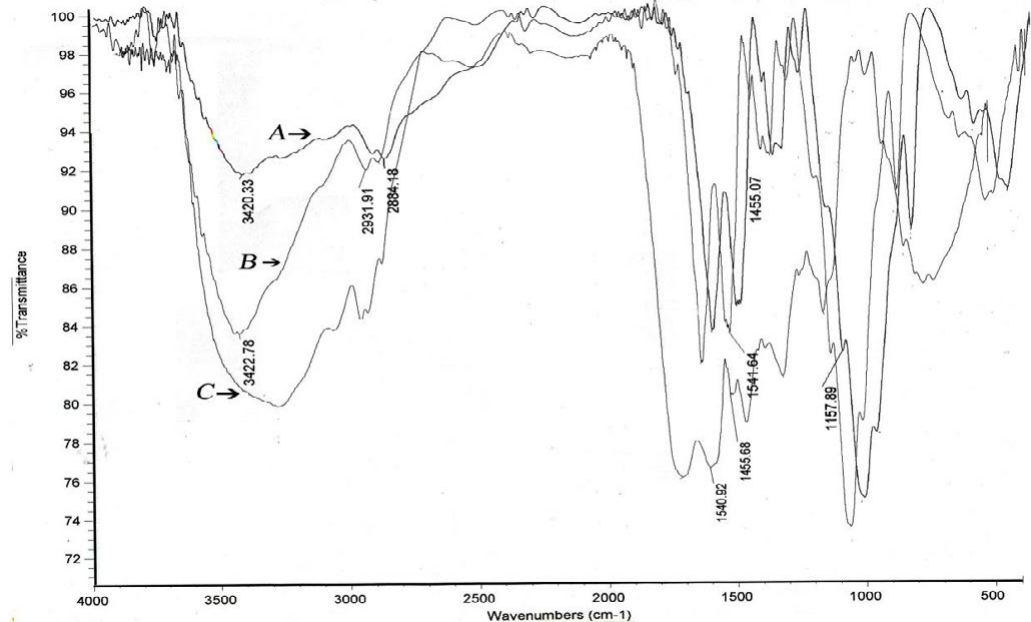
Fig. 2. FT-IR spectra of CS (A), CS-TPP nanoparticles (B) and Vipera albicornuta venom